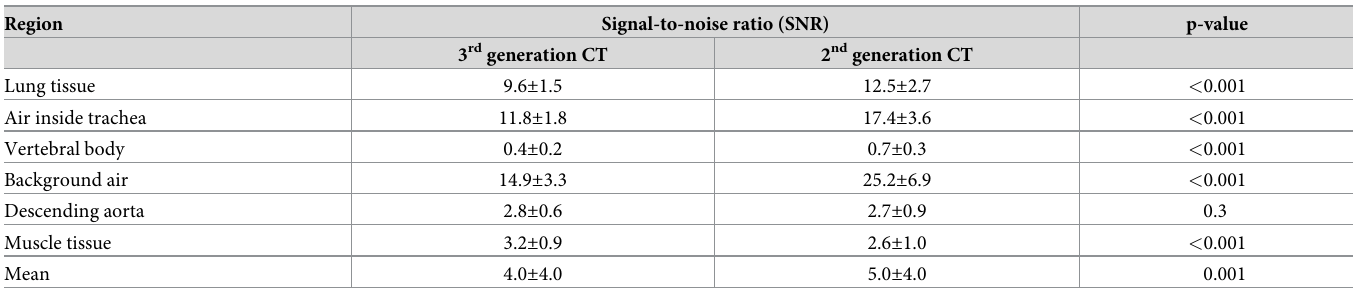
Table 5. Objective image